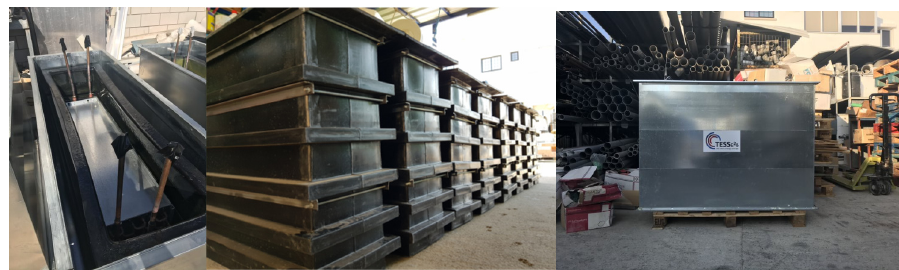
Figure 2. TES tanks (HTES, CTESs or DHW).